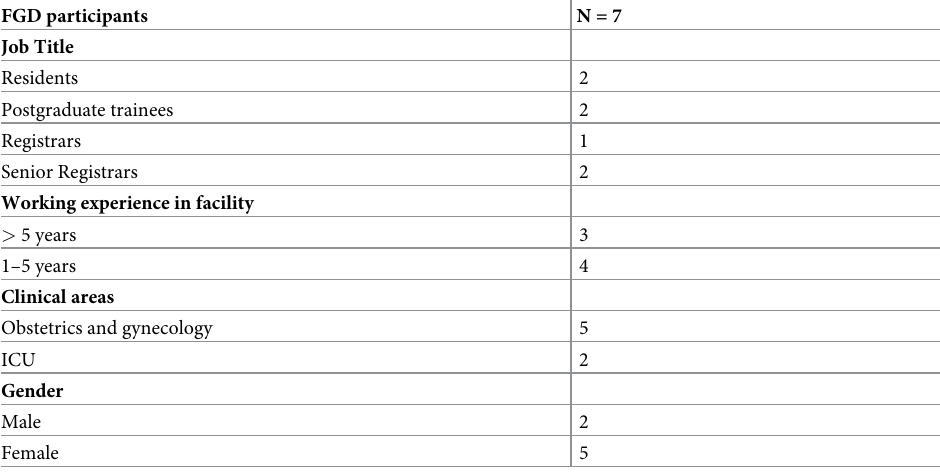
Table 2. Focus group discussion with doctors.